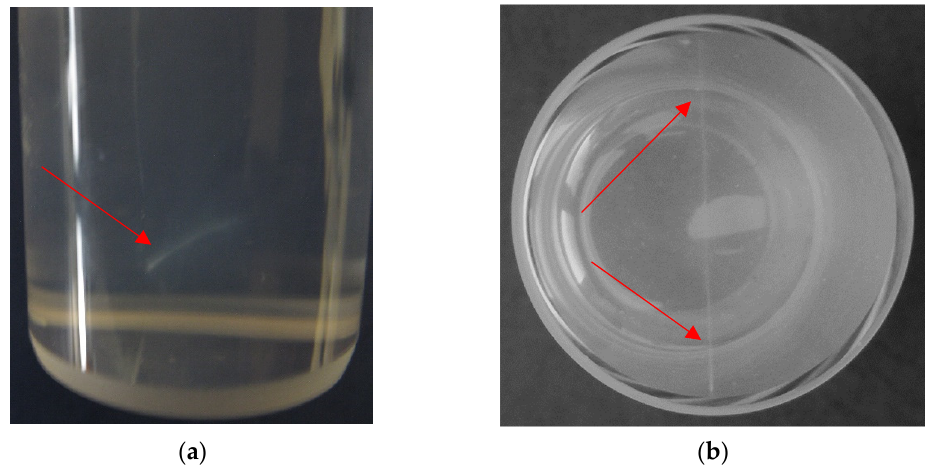
Figure 3. Side ( a ) and top ( b ) images illustrating the line—the effect of passing a green laser light of 532 nm (5 mW) through VIC-T polymer gel dosimeter. The white line across the shorter axis of the VIC-T vials (indicated with red arrows) corresponds to polymerization and crosslinking of monomeric components of VIC-T.